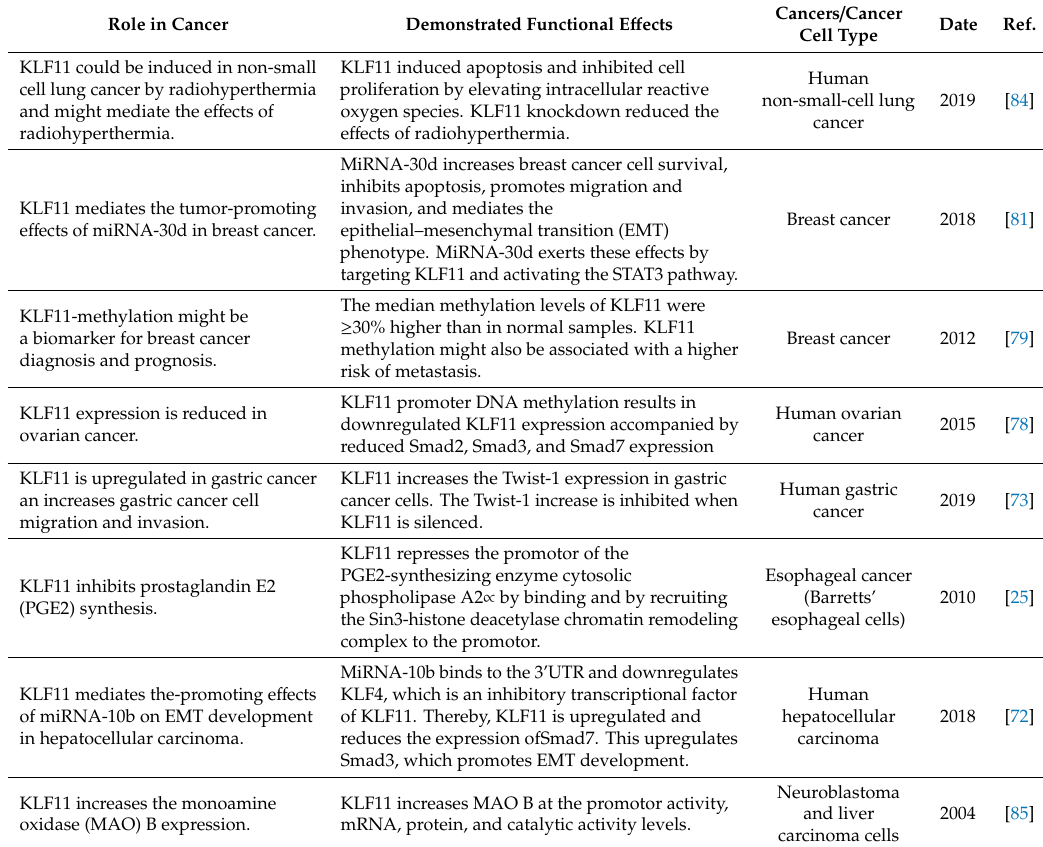
Table 3. KLF11 in